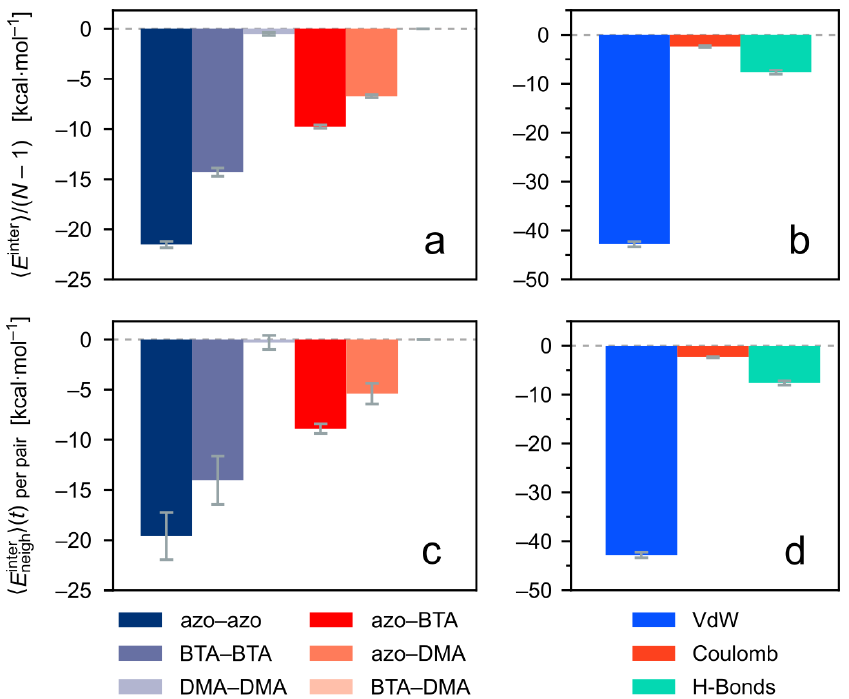
Figure 10. Decomposition of the intermolecular energies of the TrisAzo cluster with N = 36 in the equilibrium state, i.e., in the initial state before starting the CPM simulations. ( a , b ) Total intermolec- ular energies of the cluster divided by the number of neighboring monomer pairs. ( c , d ) Average intermolecular energies between directly adjacent monomer pairs. Left-hand side: energy decom- position based on the interactions between the different physical parts of TrisAzo . Right-hand side: energy decomposition based on the relevant non-covalent interactions between the